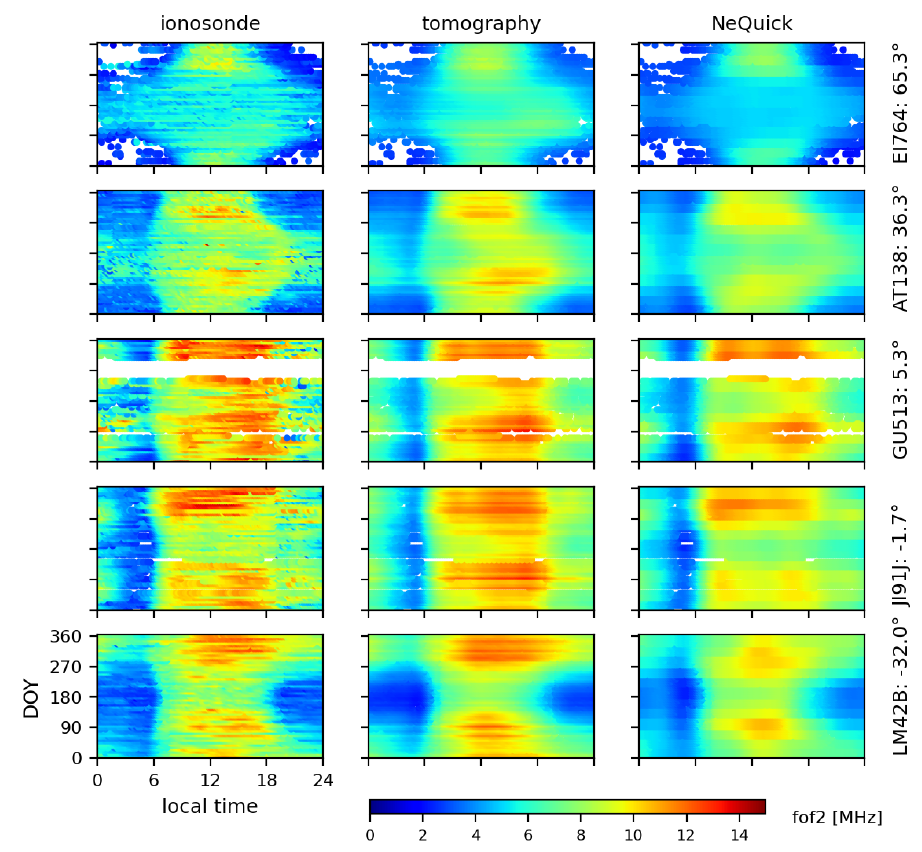
Figure 4. Critical frequency estimated in five ionosonde locations using the GIRO dataset ( left ), tomography ( middle ) and NeQuick ( right ) in terms of local time and the days of the year 2013. White spaces represent lack of